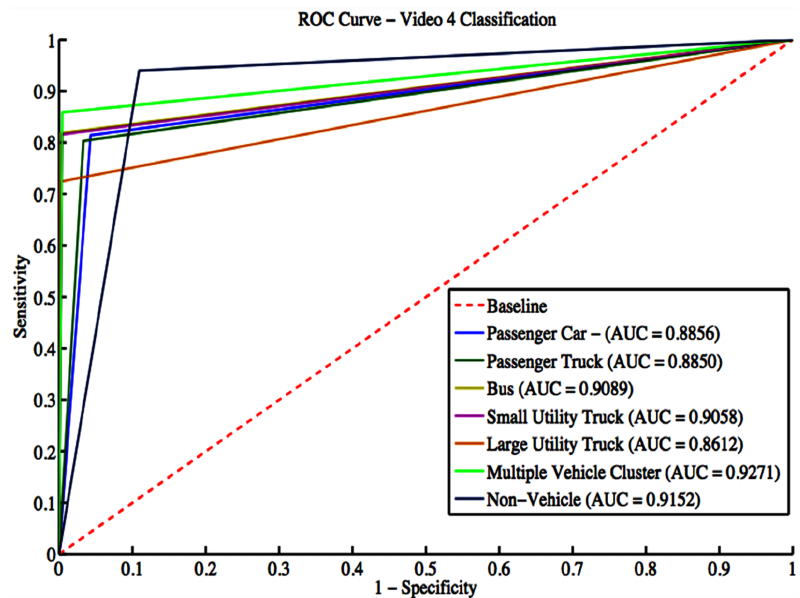
Figure 14. ROC curves for Video 4 classification. Table 18. Confusion matrix for all vehicles in Video